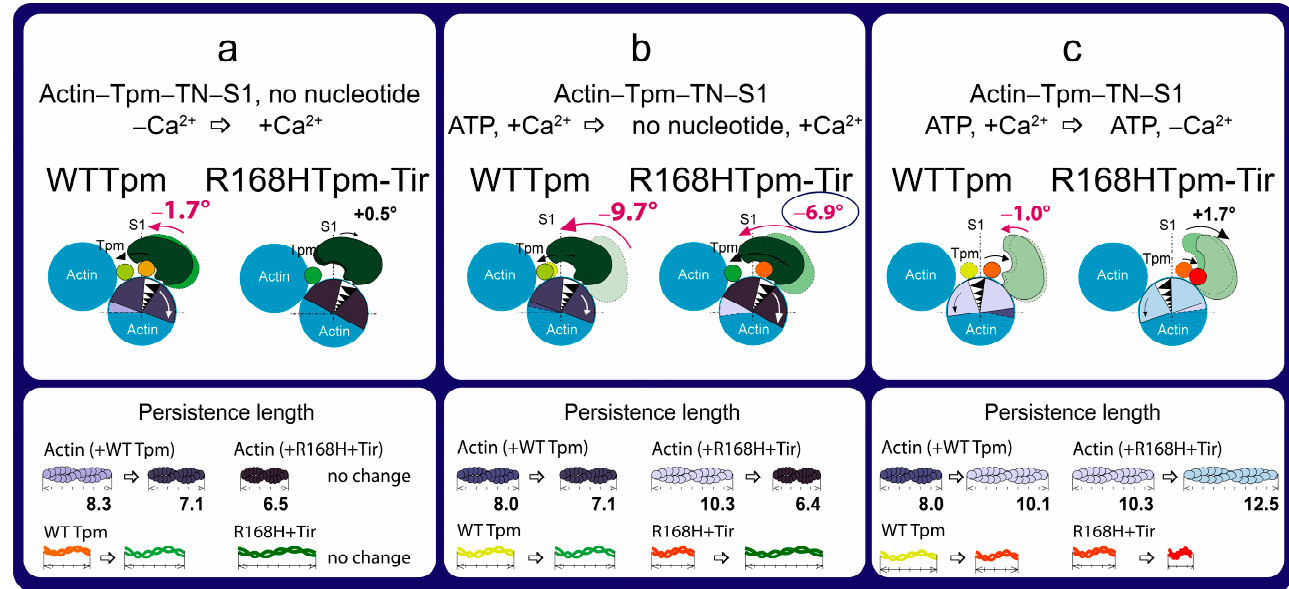
Figure 12. The scheme explains the effect of the fast skeletal troponin activator tirasemtiv (Tir) on the spatial rearrangements of myosin head, the position of the R168H-mutant tropomyosin (Tpm), the angular orientation of actin monomer, and the persistence lengths of the Tpm strands and actin filaments compared to WTTpm. Three different transitions are shown, influenced by ( a ) an increase in Ca 2+ concentration in the absence of nucleotides, ( b ) a weak-to-strong transition, and ( c ) a decrease in Ca 2+ concentration in the presence of ATP. Tirasemtiv normalizes the state at high Ca 2+ in the absence of a nucleotide and at low Ca 2+ in the presence of MgATP. Tirasemtiv does not normalize the state at low Ca 2+ in the absence of a nucleotide and at high Ca 2+ in the presence of MgATP. The designations are as in Figure 3.